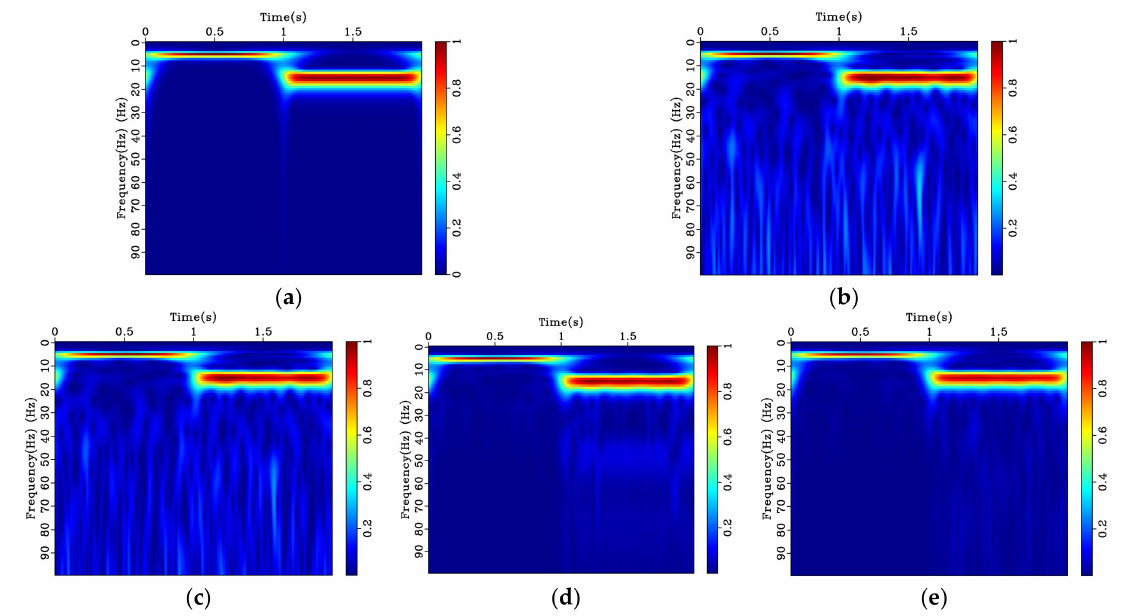
Figure 4. Time-frequency spectrum based on S transform for simulated chirp signal with random noise and denoising results: ( a ) Original signal; ( b ) original noisy signal; ( c ) signal using median filtering; ( d ) signal using wavelet denoising, and ( e ) signal using bilateral